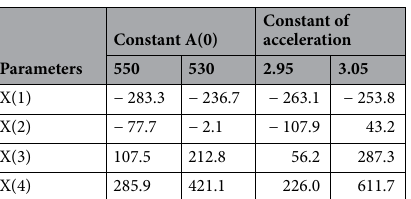
Table 2. Investigation on the initial parameters of mathematical Eq. (1).